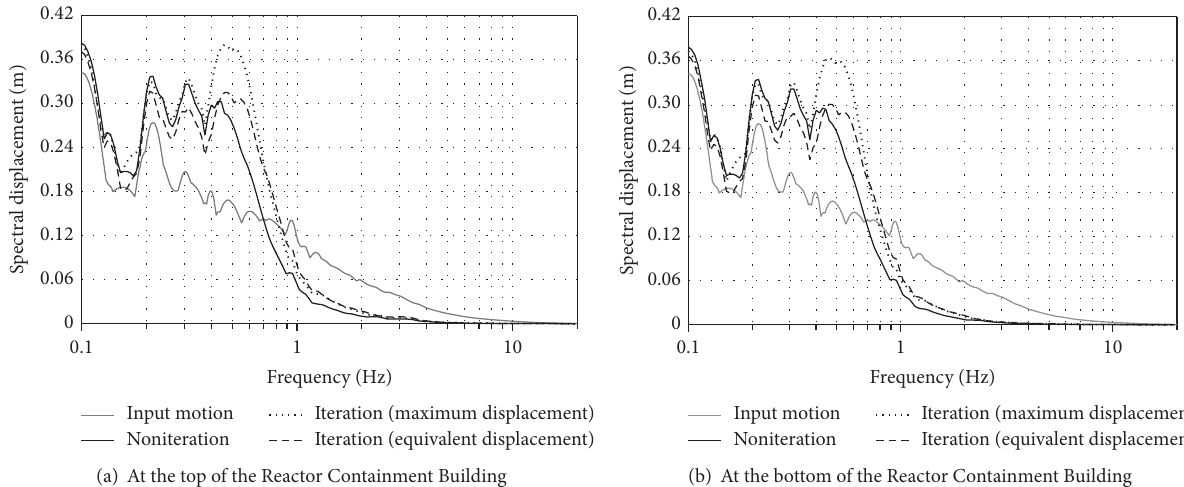
Figure 12: Comparison of the response spectral displacement for different analysis methods.